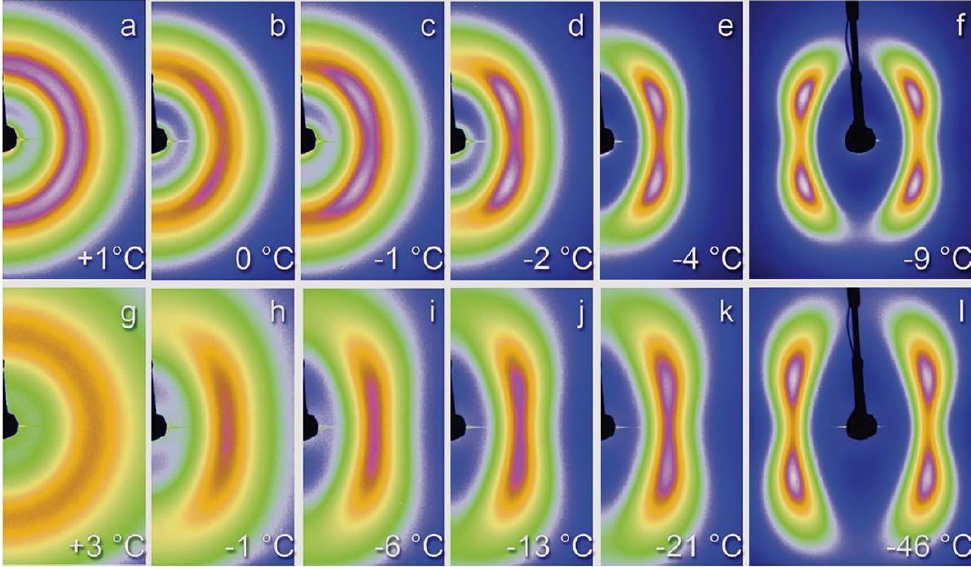
Figure 5. Low-angle XRD patterns of two representative BCMs, acquired on cooling from the isotropic melt under a horizontal magnetic field at different values of the reduced temperature T − T N–I : ( a–f ) BCM 1b ; ( g – l ) BCM 1c . Reproduced from [16] with permission from The Royal Society of Chemistry.